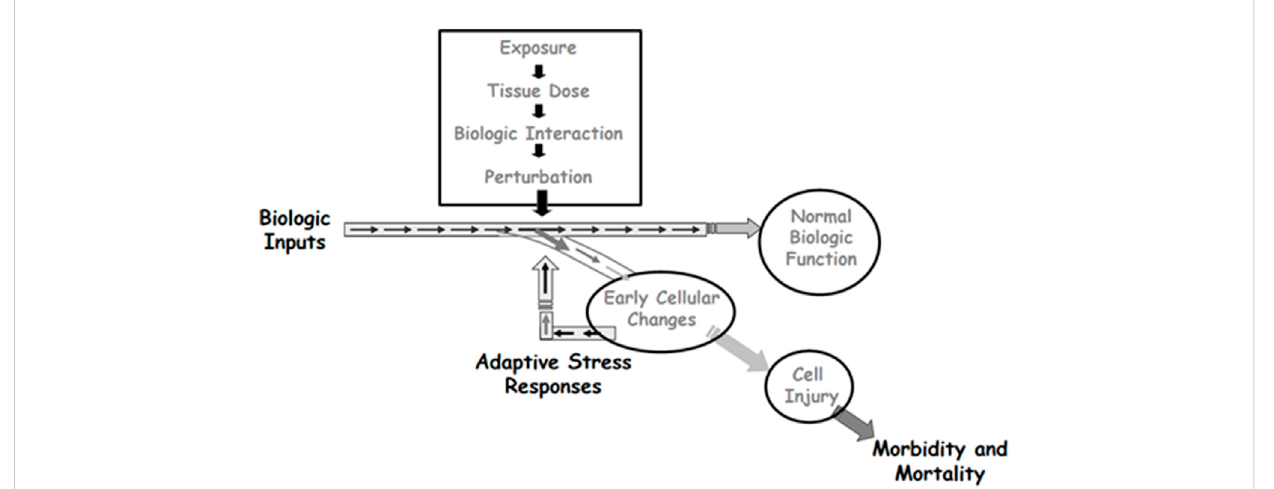
FIGURE 5 Depiction of how adaptive stress responses can lead to survival of cells that transiently experience toxic stress. When the stress includes reactive species that can damage DNA, cells that survive may carrymutations that are secondaryeffects of thetransienttoxicity. Source: Adaptedfrom